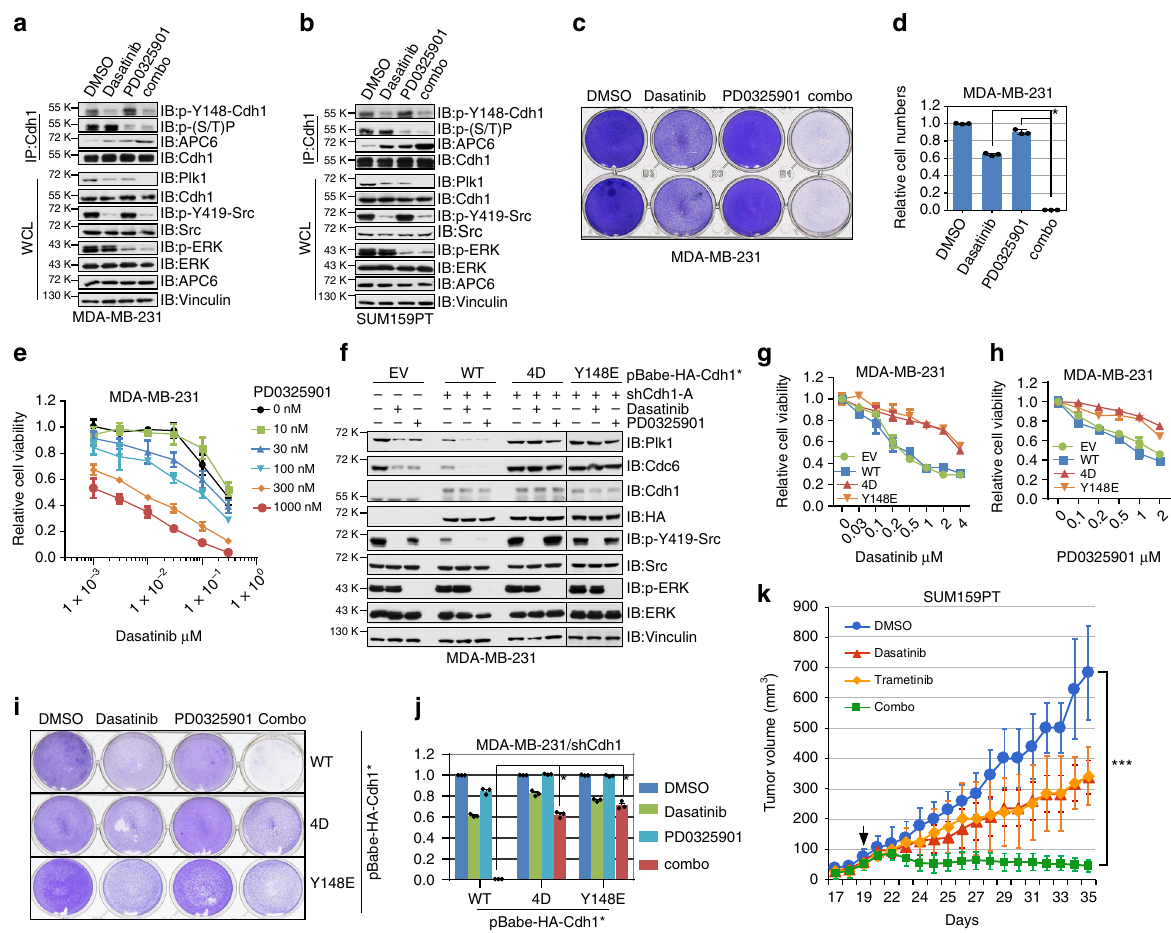
Fig. 8 Src and MEK inhibitors synergistically suppress breast cancer cell survival. a , b N -terminal phosphorylation and protein levels of APC Cdh1 ubiquitin substrates were reduced upon Src and/or MEK inhibition in MDA-MB-231 ( a ) and SUM159PT ( b ) cells. Immunoblot (IB) analysis of MDA-MB-231 ( a ) and SUM159PT ( b ) cells treated with either 100 nM Src inhibitor dasatinib, 100 nM MEK inhibitor PD0325901, a combination of these two inhibitors (combo), or DMSO as a negative control for 24 h before harvest. c , d Cells were treated with 300 nM dasatinib, 300 nM PD0325901, or the combination of dasatinib with PD0325901 for 3 days before being fi xed and stained with crystal violet ( c ). Relative colony numbers were calculated as mean ± SD ( n = 3). * P < 0.05; Student ’ s t test ( d ). e Dose – response curves of MDA-MB-231 cells treated with dasatinib, PD0325901 or the combination. Relative cell viability was determined after 72 h treatment. Combination indexes (CI) were calculated using the CompuSyn software as shown in Supplementary Fig. 8j. f IB analysis of EV-, WT-Cdh1-, 4D-Cdh1-, and Y148E-Cdh1-expressing MDA-MB-231 cells treated with either 300 nM dasatinib, 300 nM PD0325901, or DMSO as a negative control for 24 h before harvest. *Cdh1 cDNA used in this experiment has been mutated to escape sh Cdh1 -mediated gene silencing. g , h Dose – response curves of EV-, WT-Cdh1-, 4D-Cdh1-, or Y148E-Cdh1-expressing MDA-MB-231 cells treated with dasatinib ( g ) and PD0325901 ( h ). Relative cell viability was determined after 72 h treatment. i , j WT-, 4D-, and Y148E-Cdh1-expressing MDA-MB-231 cells were treated with 300 nM dasatinib, 300 nM PD0325901, or the combination of dasatinib with PD0325901 for 3 days before being fi xed and stained with crystal violet ( i ). Relative colony numbers were calculated as mean ± SD ( n = 3). * P < 0.05; Student ’ s t test ( j ). k Growth curves of the SUM159PT xenograft tumors with the vehicle, dasatinib, trametinib or the combinational treatment started as the arrow indicates. In each fl ank of six nude mice, 3 × 10 6 cells were injected. The tumor volumes were measured at the indicated days. Error bars represent ± SEM ( n = 8). *** P < 0.001; Student ’ s t